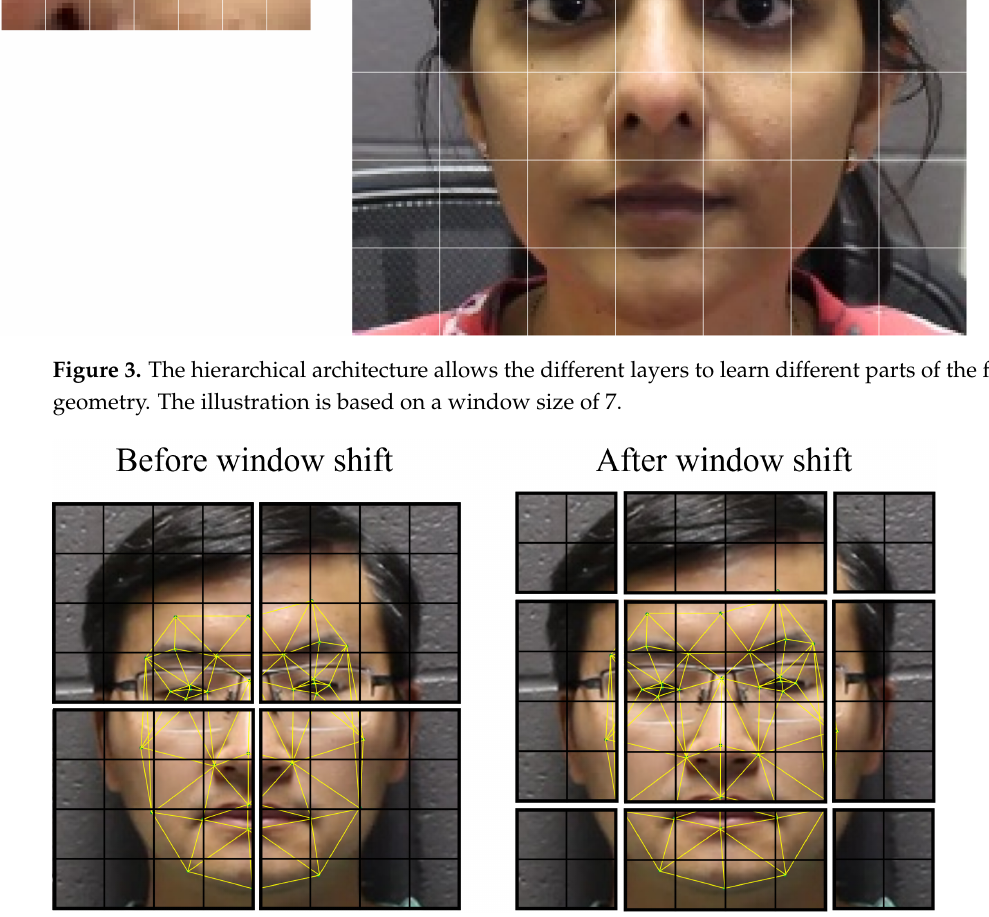
Figure 4. Because of localized attention windows, a mechanism is needed to represent fine-grained relationships across window borders. Window shifting provides this mechanism. By shifting the attention windows borders every other layer, we can model the relationships between each image patch and all nearby